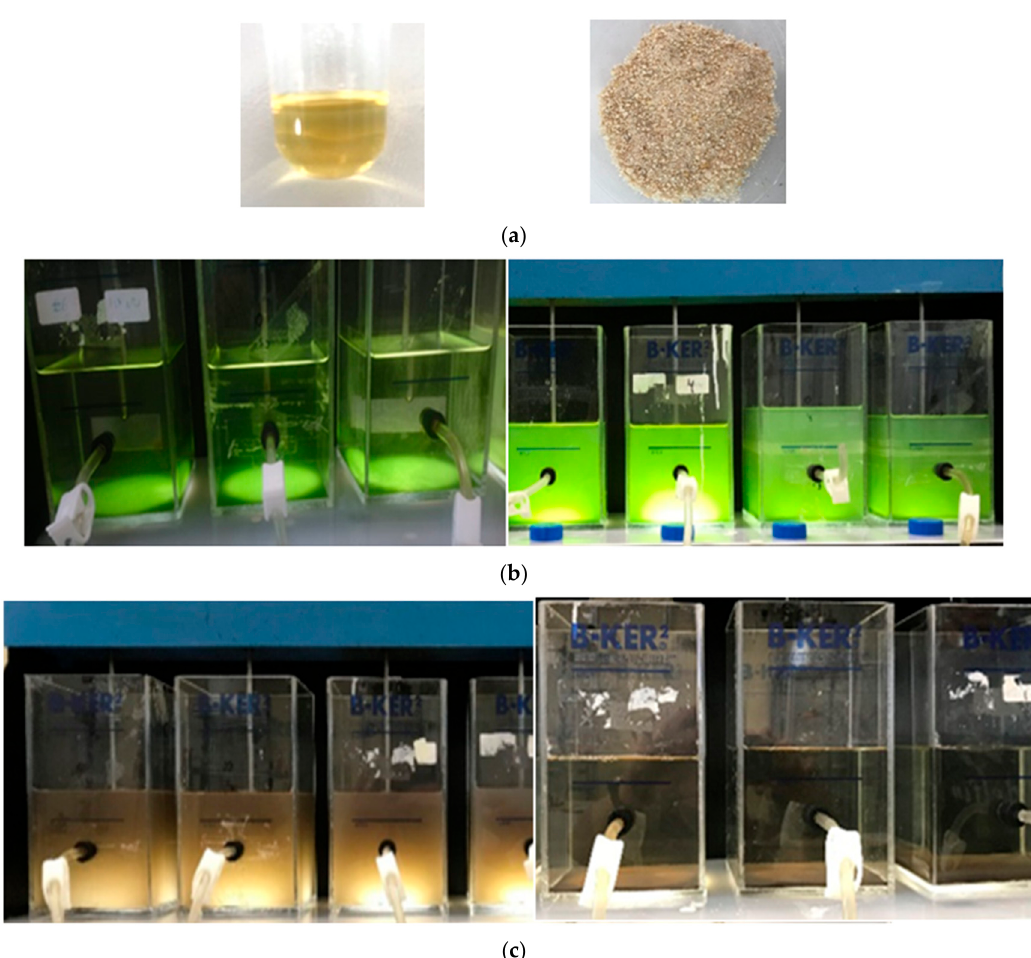
Figure 1. Jar test, dose determination, and optimal pH during the algal flocculation with urban wastewater: ( a ) Oil extraction from Moringa oleifera seed; ( b ) flocculation with microalgae culture; and ( c ) flocculation with urban wastewater.